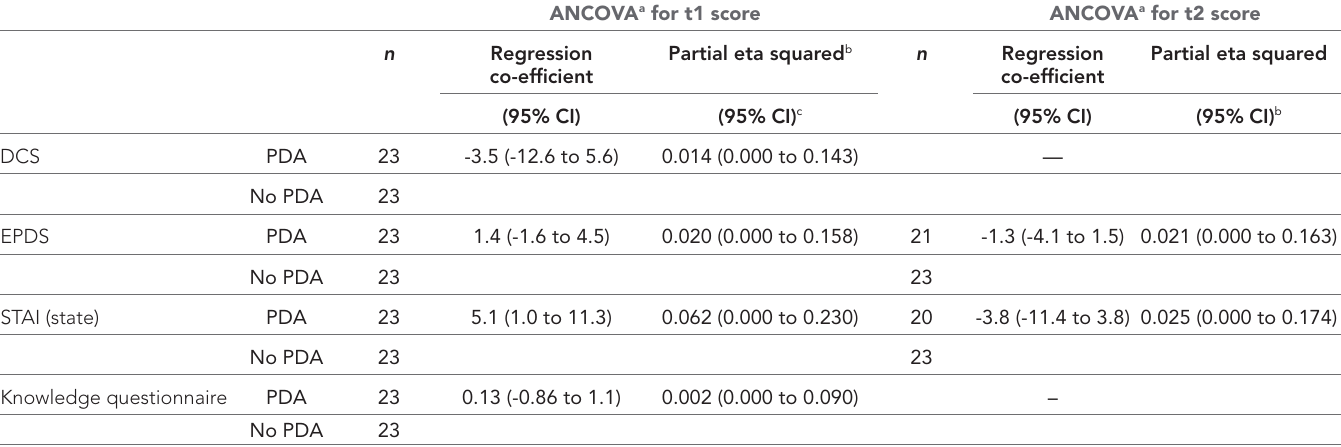
Table 3 Efficacy outcomes: analyses of